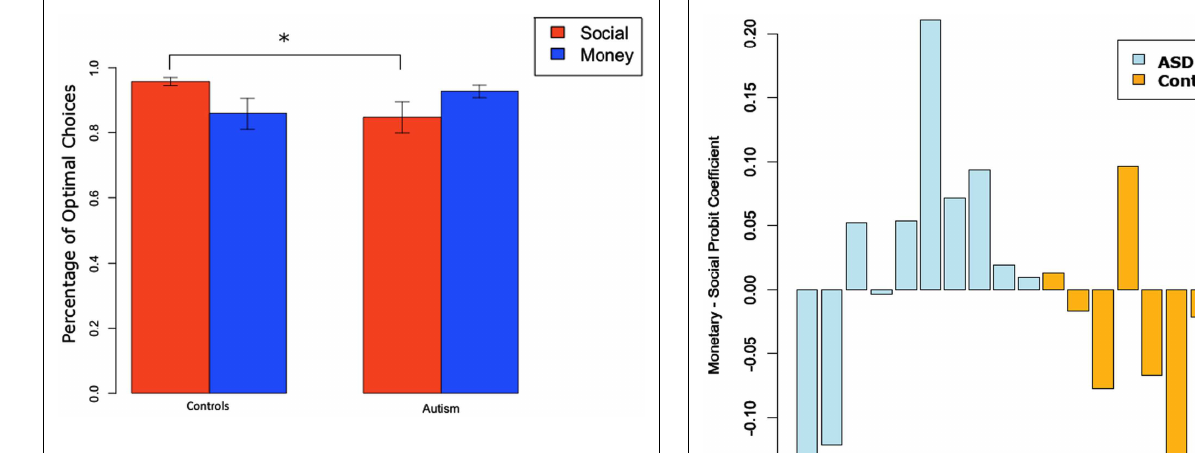
FIGURE 5 |Total percentage of optimal slot machine selection (mean and SEM) for positive trials in social and monetary condition.